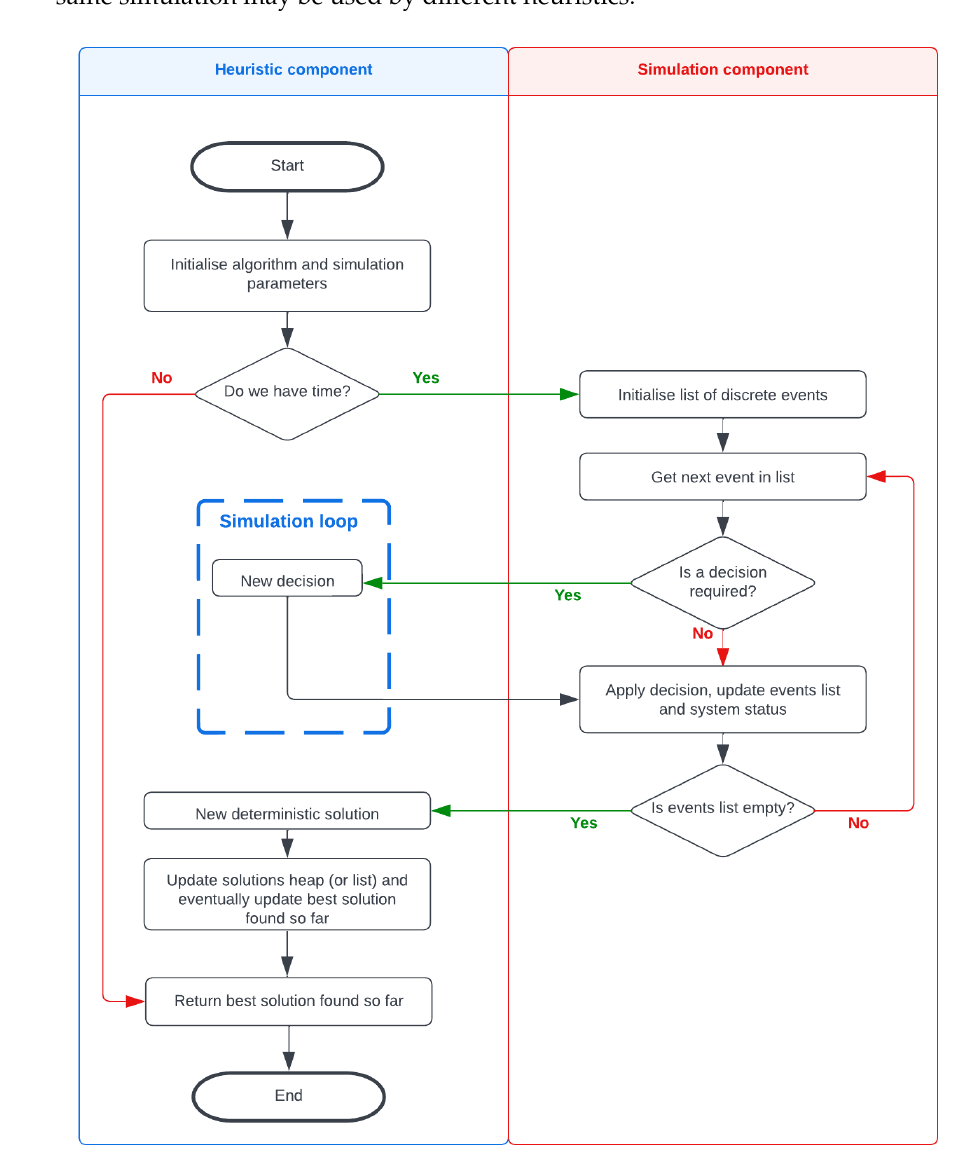
Figure 5. Flowchart of a discrete-event heuristic for the